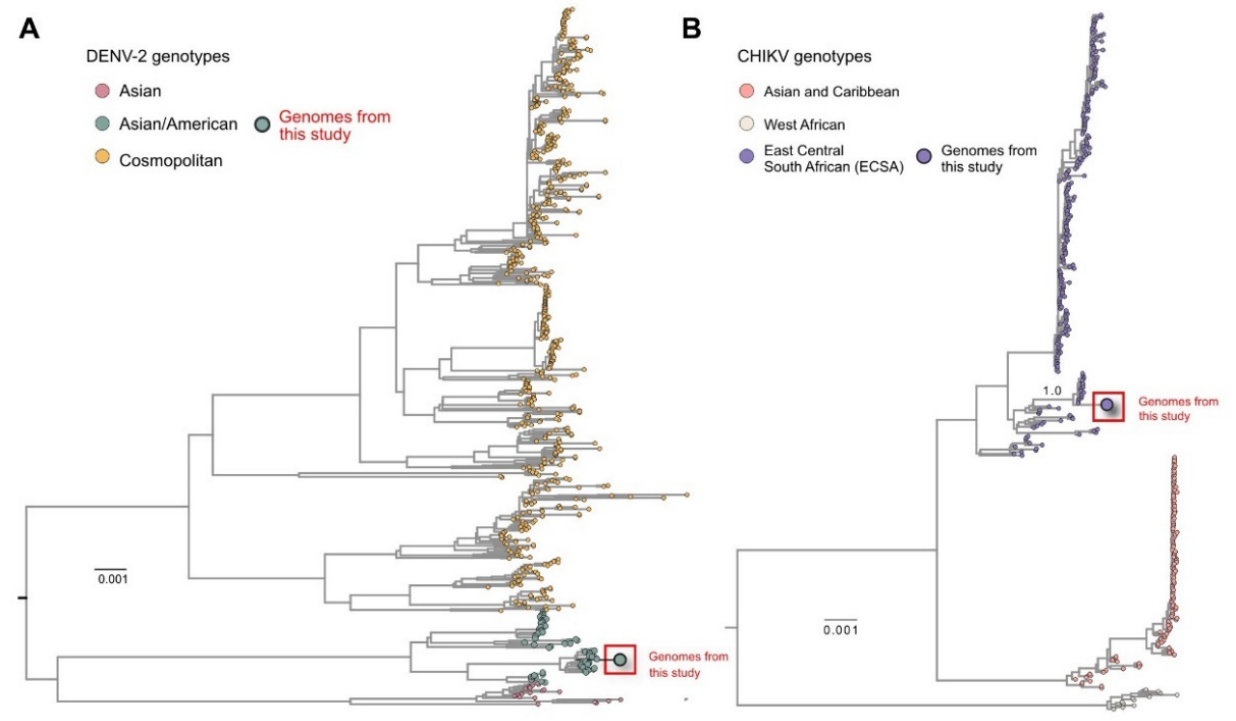
Figure 2. Phylogenetic analysis of the obtained complete Dengue and Chikungunya complete genomes. ( A ) Maximum likelihood tree showing that the new Dengue virus-2 genome sequences obtained in this study belonged to the Asian/American genotype and clustered together with other strains obtained from Brazil during the 2019–2020 DENV outbreak, especially strains that circulated in the S ã o Paulo state. ( B ) Maximum likelihood tree analyzing complete Chikungunya genome sequence indicating that it belongs to the ECSA genotype, which is circulating in Brazil and especially the northeast, where the sample collection was